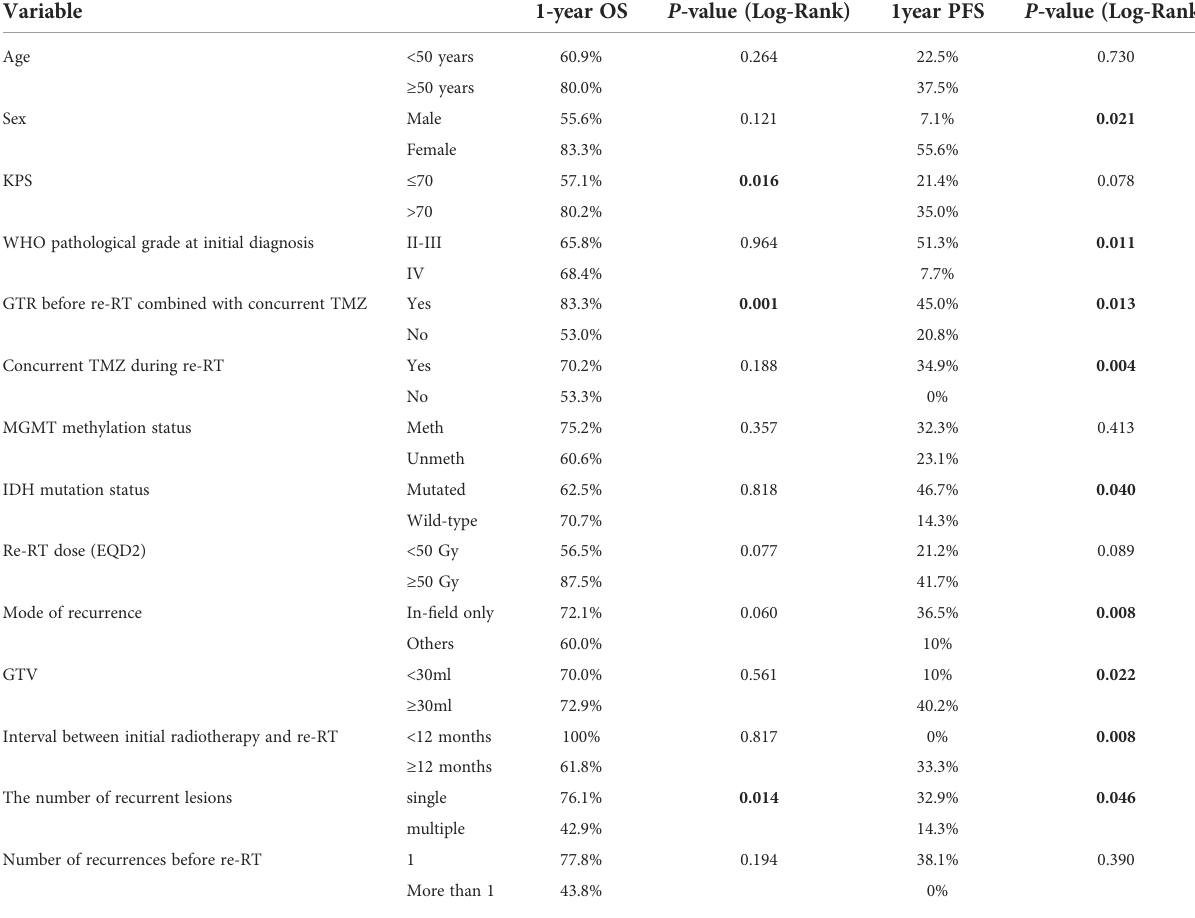
TABLE 3 Univariate analysis for OS and PFS.